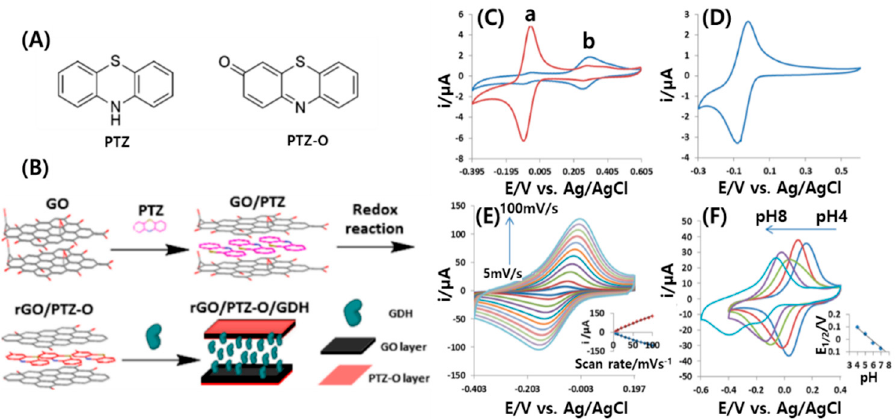
Figure 11. ( A ) Chemical structures of phenothiazine (PTZ) and 3H-phenothiazine-3-one (PTZ-O). ( B ) Schematic representation of the procedure for preparing the rGO-based bio-composite. Cyclic voltammograms (CVs) of GC electrodes: ( C ) (a) rGO/PTZ after oxidation and (b) PTZ in solution; ( D ) pure PTZ-O extracted from rGO; ( E ) different scan rates. Inset: scan rate ‐ dependent peak currents of